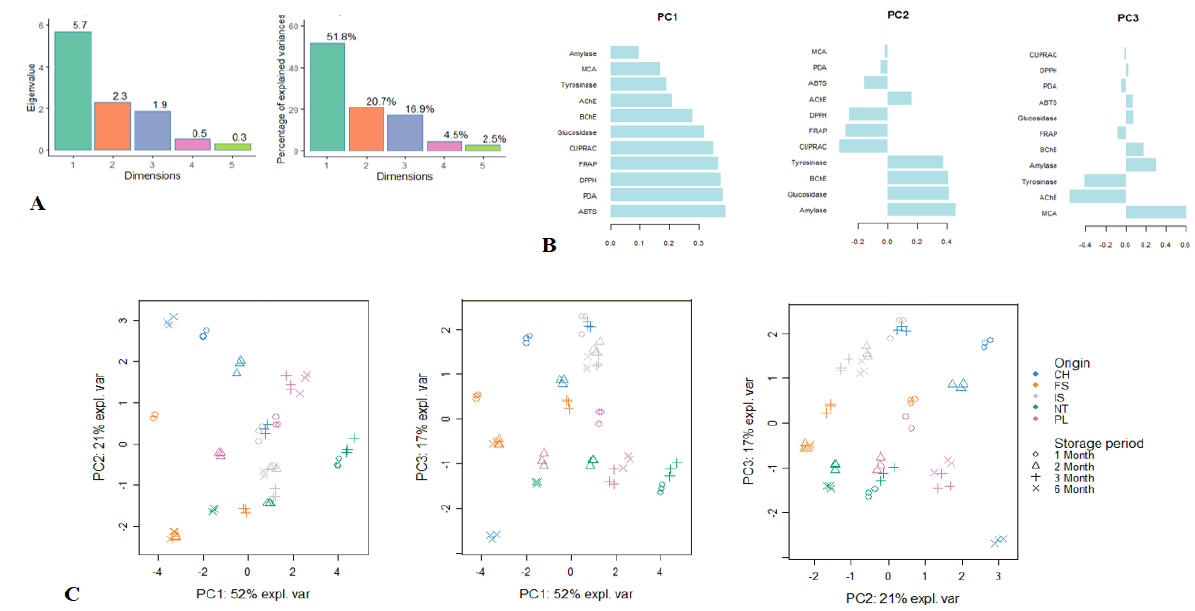
Figure 3. Principal component analysis (PCA) showing the variability of the antioxidant and anti-enzymatic activity of comfrey roots depending on the storage period and geographical region. ( A ). Eigenvalues and percentage of explained variance of each principal component (PC). ( B ). Loading plots displaying the relationship between the biological activities and the three significant PCs. ( C ). Score plots showing the distribution of the samples in the three two-dimensional plans obtained from the three significant PCs. ABTS, 2,2′ -azino-bis(3-ethylbenzothiazoline) 6-sulfonic acid; AChE, acetylcholinesterase; BChE, butyrylcholinesterase; CUPRAC, cupric ion reducing antioxidant capacity; DPPH, 1,1-diphenyl-2-picrylhydrazyl; FRAP, ferric ion reducing antioxidant power; MCA, metal chelating activity; PDA, phosphomolybdenum activity.